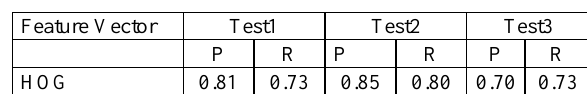
Figure 10. The regularized